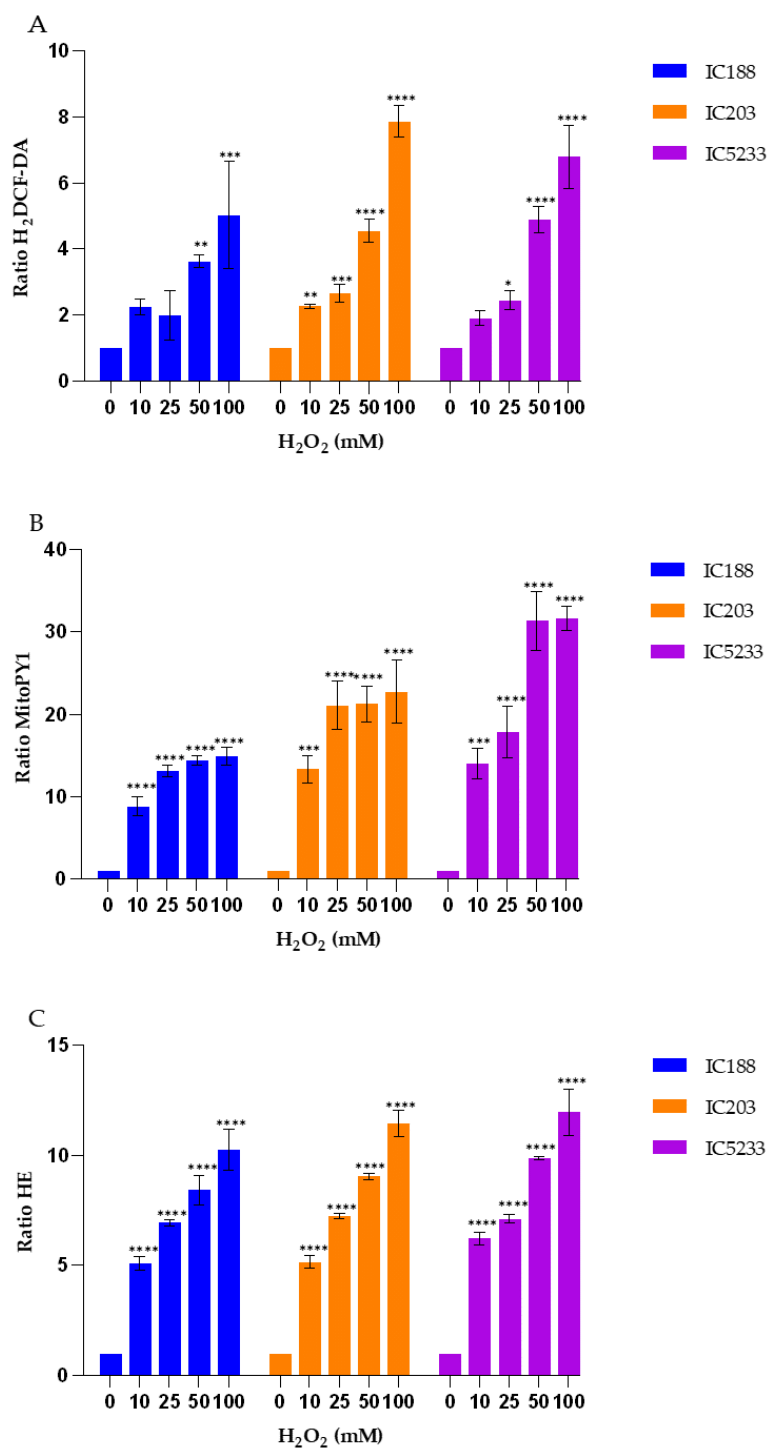
Figure 5. Fluorescence response to exogenous H 2 O 2 of the fluorescent probes ( A ) H 2 DCF-DA, ( B ) MitoPY1 and ( C ) HE in the strains IC188, IC203 and IC5233. Results are the mean ± SD (n = 3) of the fluorescence ratios of the product resulting from intracellular probe oxidation. (* p < 0.05, ** p < 0.01, *** p < 0.001 and **** p < 0.0001 in Anova